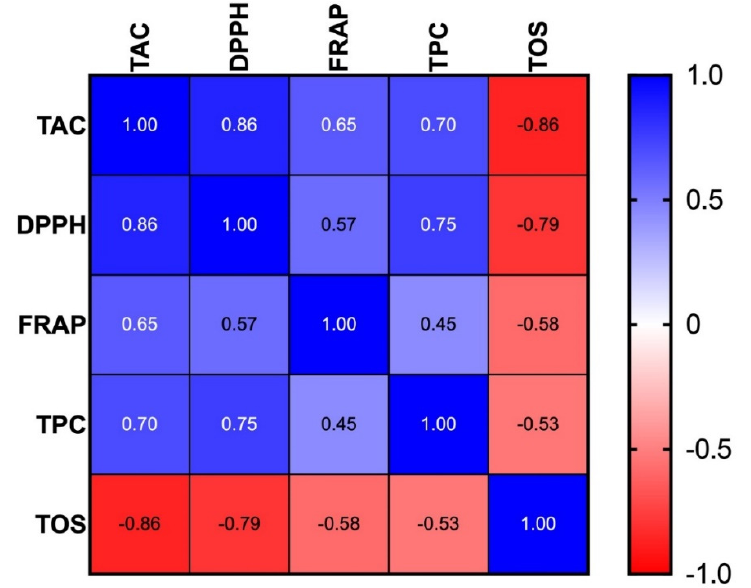
Figure 1. Heatmap of correlations between the analyzed antioxidant parameters. DPPH—Radical scavenging activity assay; FRAP—Ferric Reducing Antioxidant Power; TAC—Total antioxidant capacity; TOS—Total oxidant status; TPC—Total phenolic content.